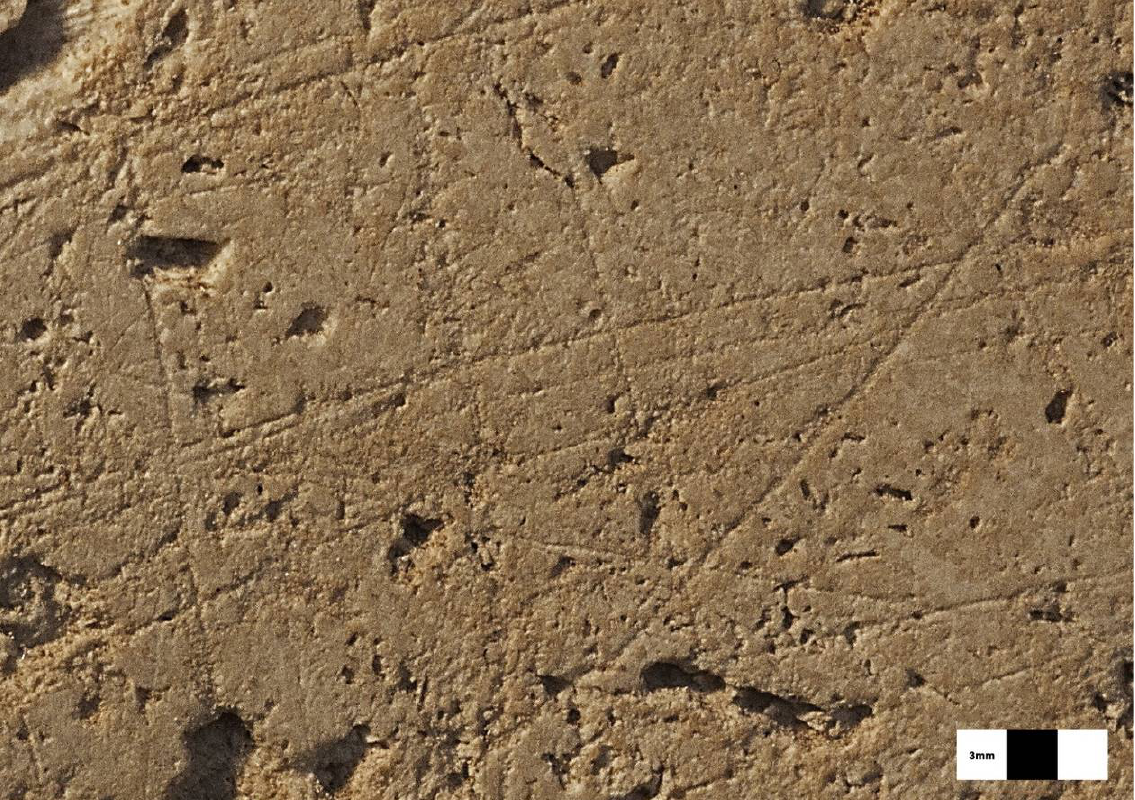
Figure 11. An enlargement of the grid-like pattern (photograph by E. Crater